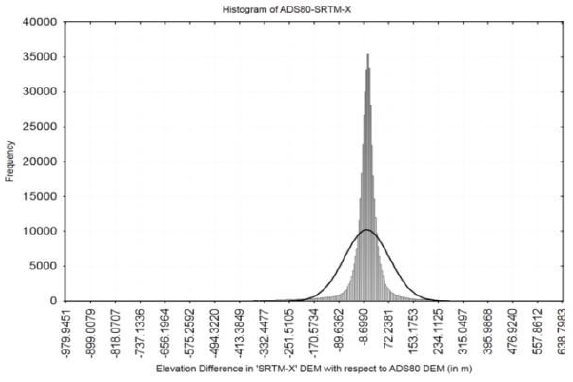
Figure 7: Histogram of the Error (Difference)